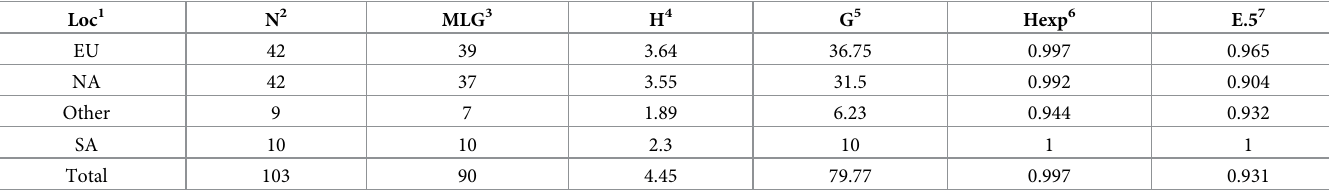
Table 3. Summary statistics for each sampling